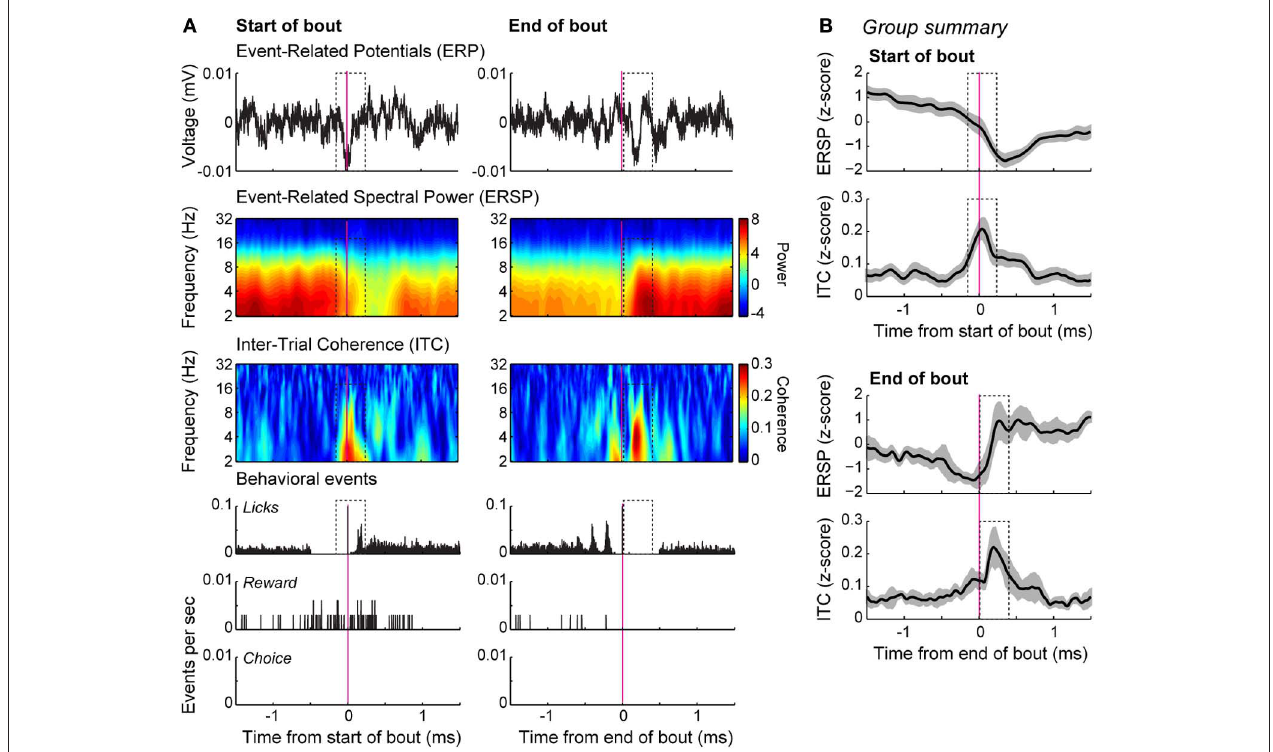
histograms for the behavioral events are shown below the spectral plots. (B) Group summary of the ERSP and ITC values for the onsets and offsets of the bouts are shown for the database of 54 field potentials recorded from 4 rats. The plots show the average level of power and coherence and 95% confidence intervals are indicated by the gray bands. The dashed boxes highlight the same temporal epochs that are highlighted in (A) , where there was consistent phase locking in the theta range bracketing the bouts of